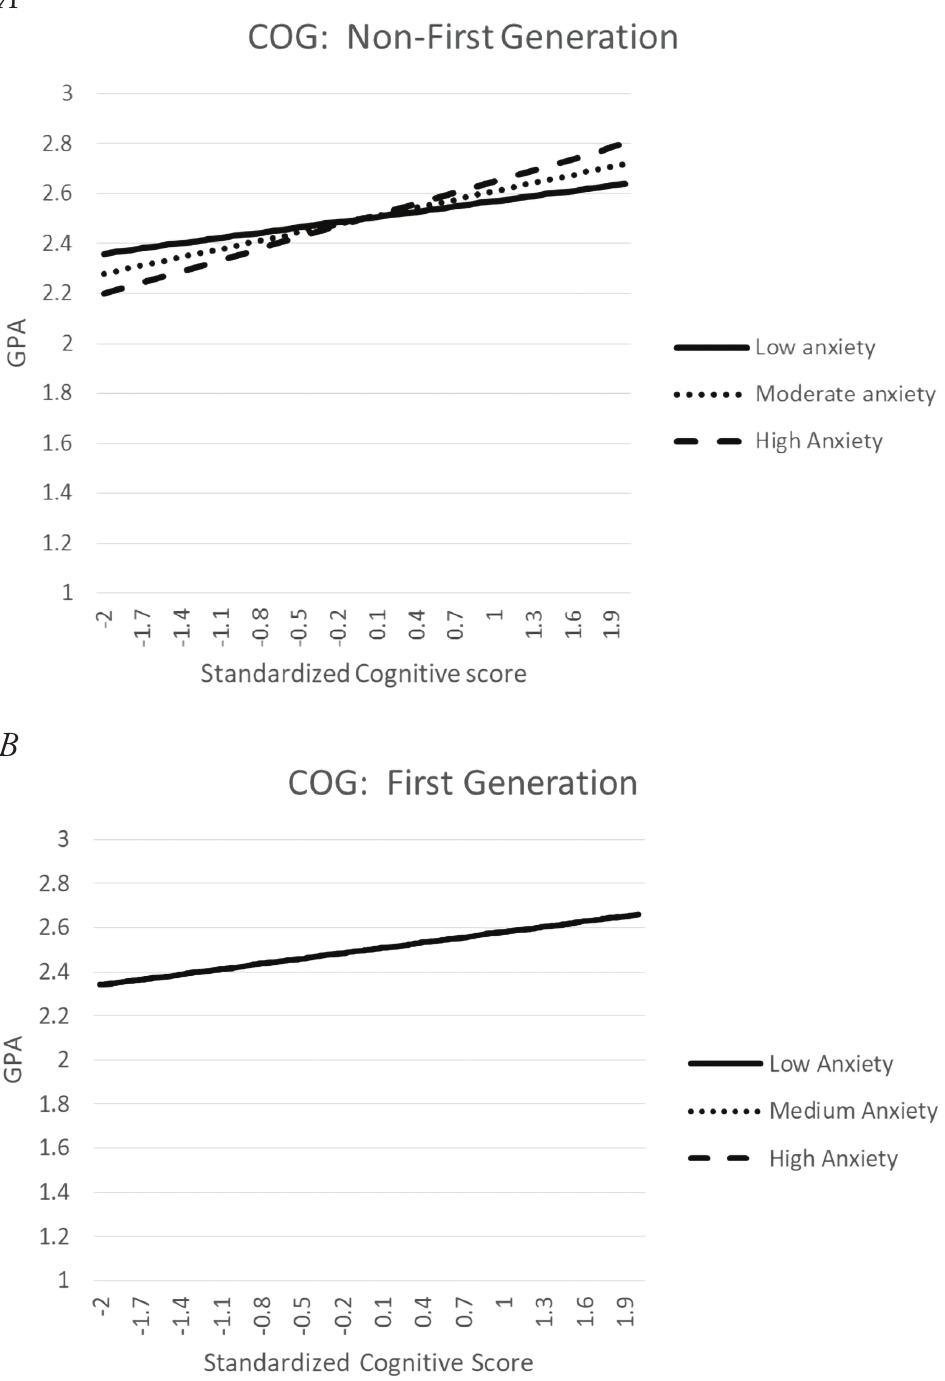
Figure 2. Total Relationship between Cognitive Skills and GPA at Low, Moderate, and High